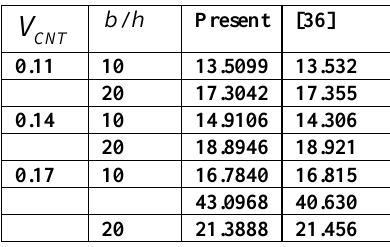
Table 4. The non–dimensional natural frequencies of composite plate reinforced by CNT